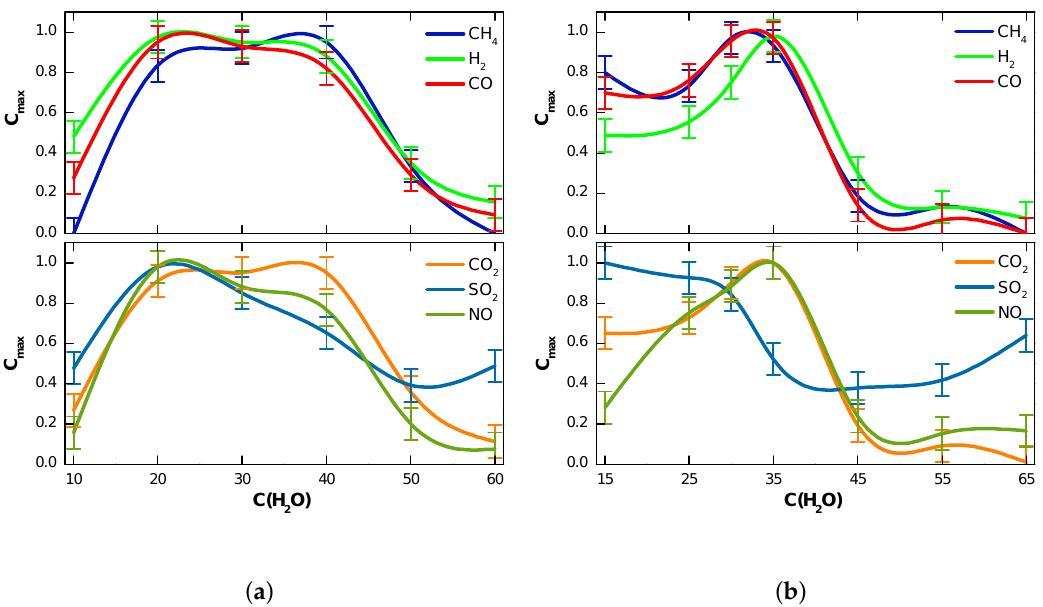
Figure 3. Chemical composition of syngas vs. moisture content of fuel composition. The products of peat and lignite conversion are shown in ( a , b ), respectively. The normalization factors for the concentrations of each gas are shown Table 2. Table 2. Normalization factors for the concentrations of syngas components presented in Figure